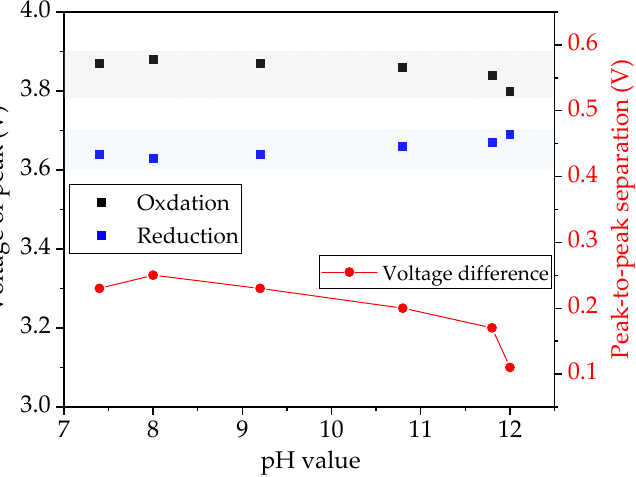
Figure 9. Redox peak voltage extracted from Figure 8 and the redox couple voltage difference of cells with electrodes produced with different slurry pH values.